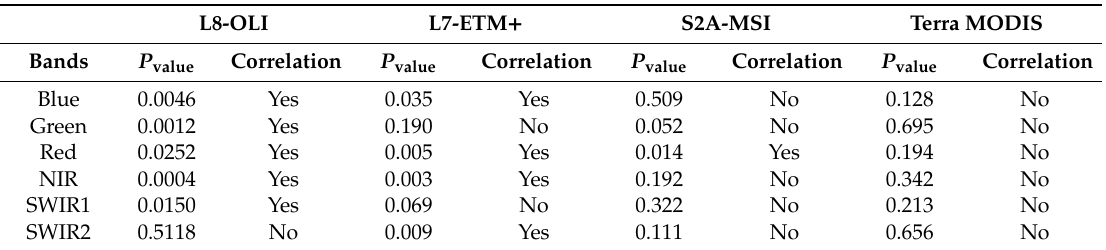
Table 4. Correlation between Decimal Year and BRDF Corrected Mean TOA Reflectance of Libya 4.